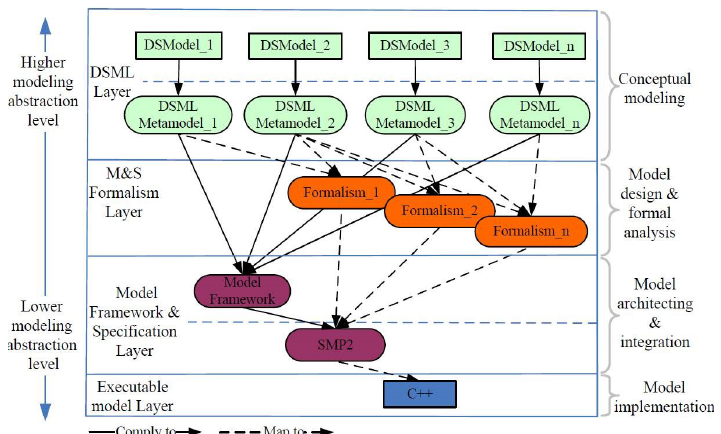
Fig. 3 Radar system simulation hierarchical framework based on virtual reality